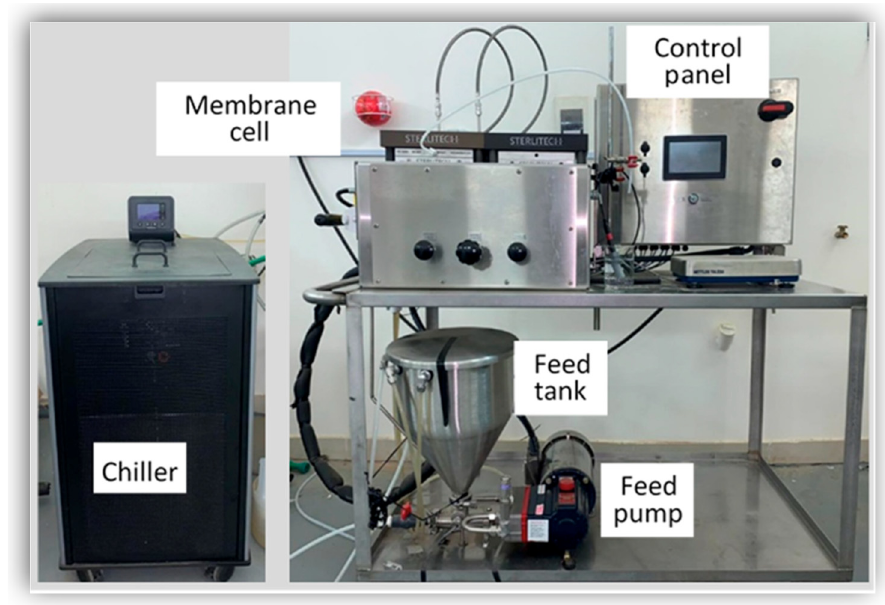
Figure 1. SEPA CF Cell Membrane Test Skid.